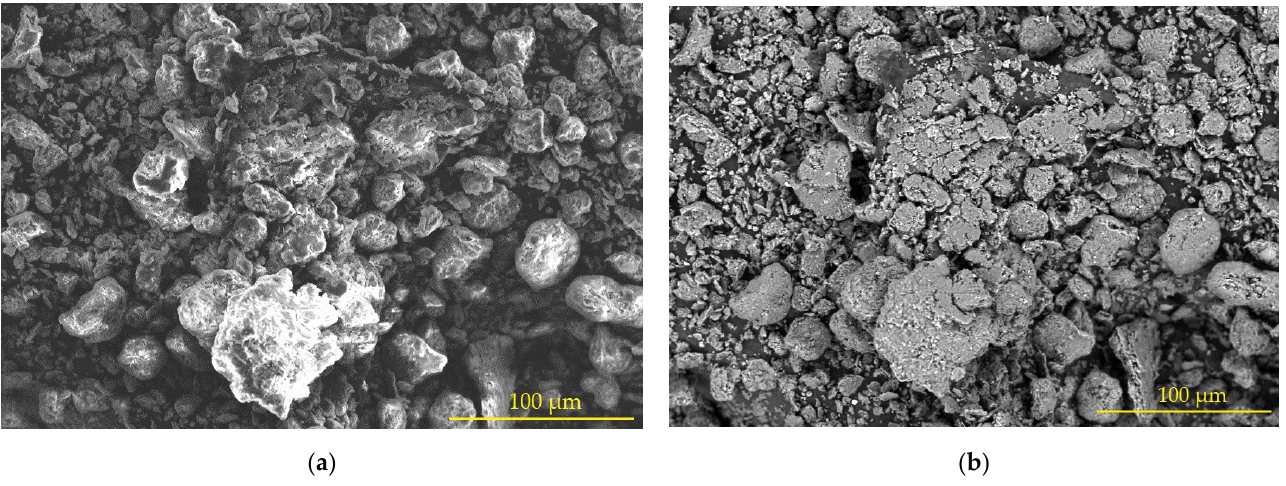
Figure 3. Scanning electron microscopy (SEM) in a bentonite sample: ( a ) variability of grain size; ( b ) surface